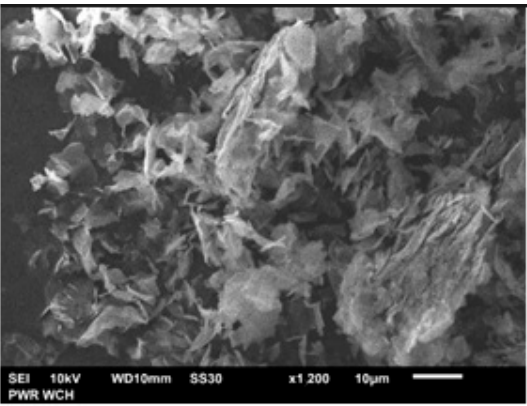
Figure 3. Representative SEM image of the Fe 3 O 4 @graphene nanocomposite.